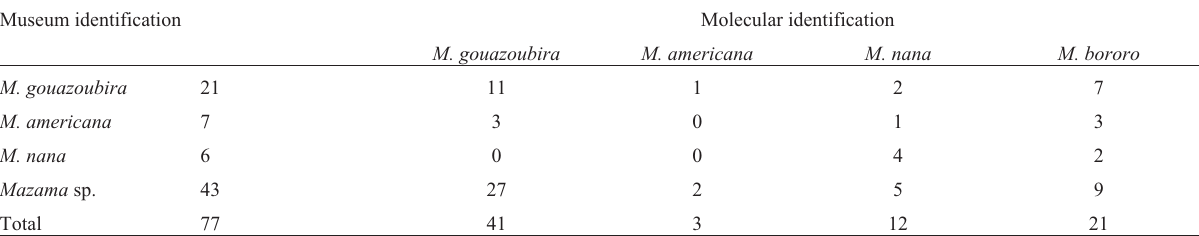
Table 3 - Comparison among the morphological information of 77 specimens identified with Cytb from Brazilian museum